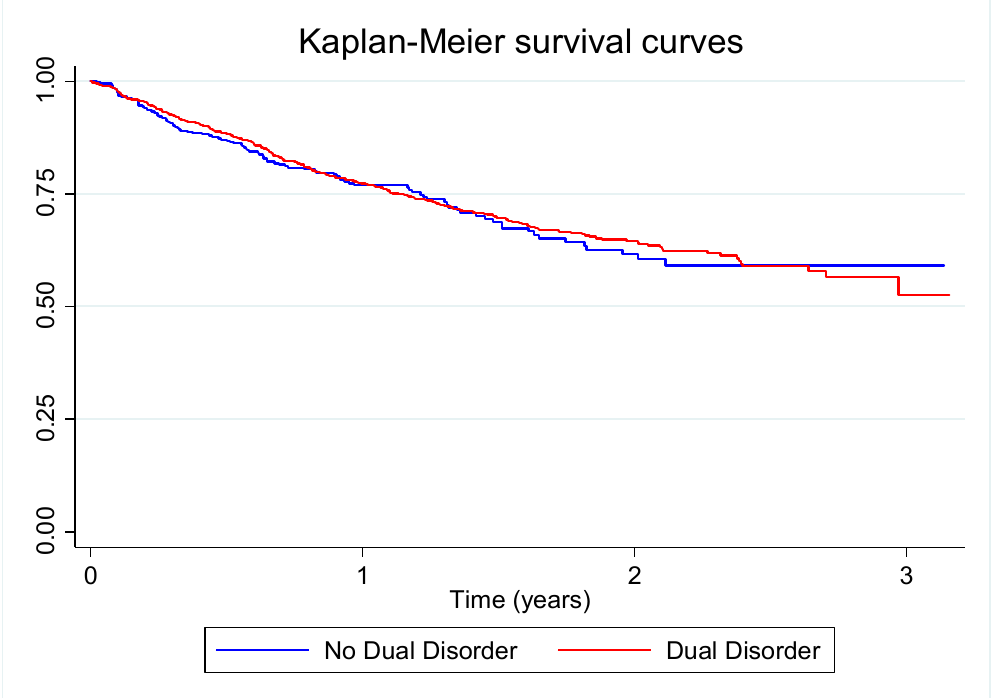
Figure 1. Kaplan–Meier survival curves for treatment retention by DDSI-IV result in a cohort of individuals with alcohol or cocaine use disorder ( n = 1356). Outpatient drug dependence care centres in Barcelona, January 2015–February 2018.